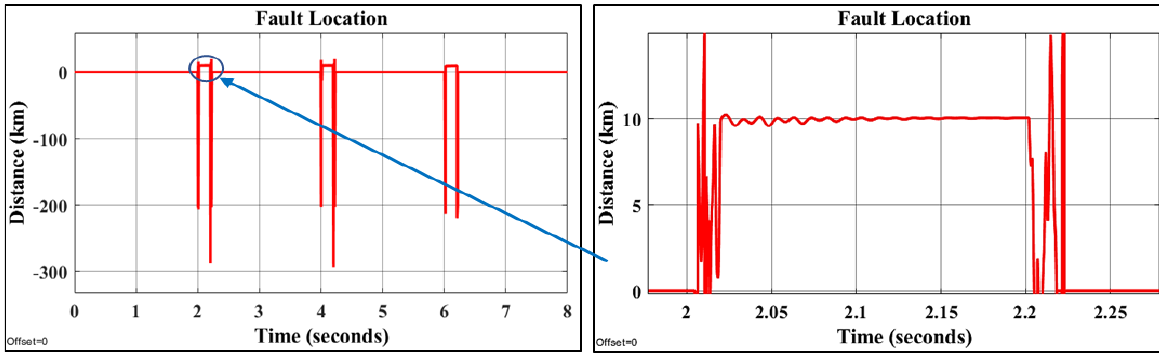
Figure 19. Fault location (Scenario 3, Case 2) .